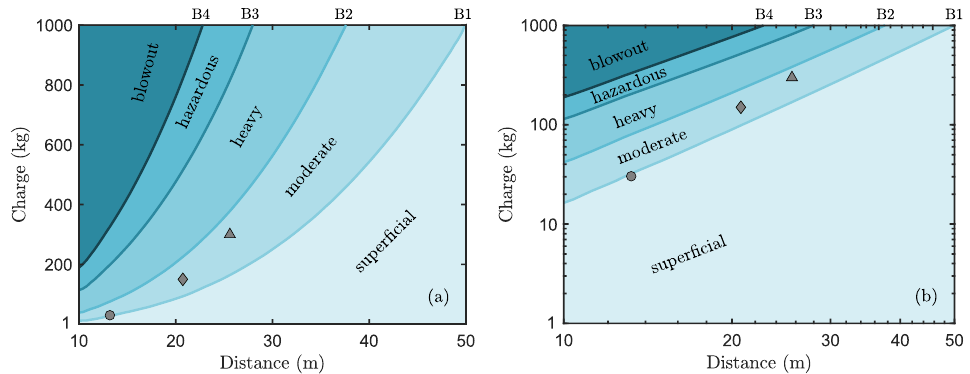
Figure 13. CW–S linear ( a ) and log-log ( b ) damage diagrams for reflected blast load on the façade of the first floor (Level 1): Case 1 ( (cid:13) ), Case 2 ( ♦ ), Case 3 ( (cid:52)